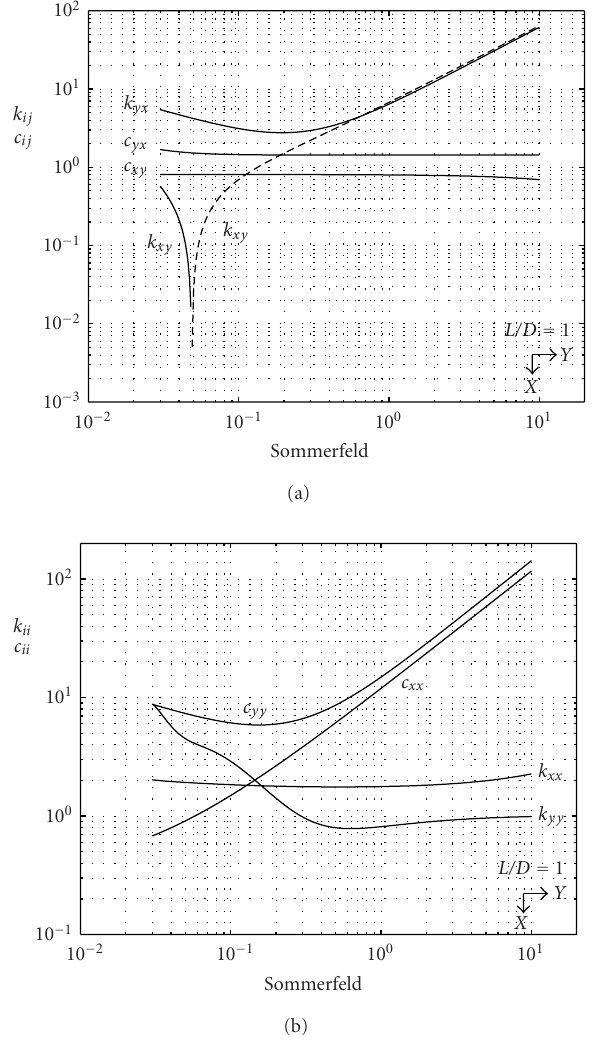
Figure 2: Sti ff ness and damping rotordynamics coe ffi cients of cylindrical bearing for P s = 0, equivalent to conventional circular journal bearings: (a) cross-coupled coe ffi cients and (b) direct coef-